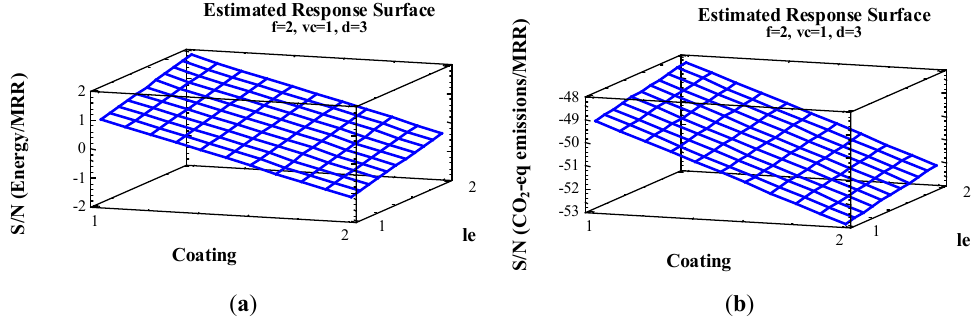
Figure 8. ( a ) Values of the S/N ratio (Energy/MRR) with respect to coating and le ; ( b ) Values of the S/N ratio (CO 2 -eq emissions/MRR) with respect to coating and le. Therefore, linear regression can explain the relationship between S/N Energy/MRR) and S/N (CO 2 -eq emissions/MRR). The output shows the results of fitting a linear model via Equation (2).